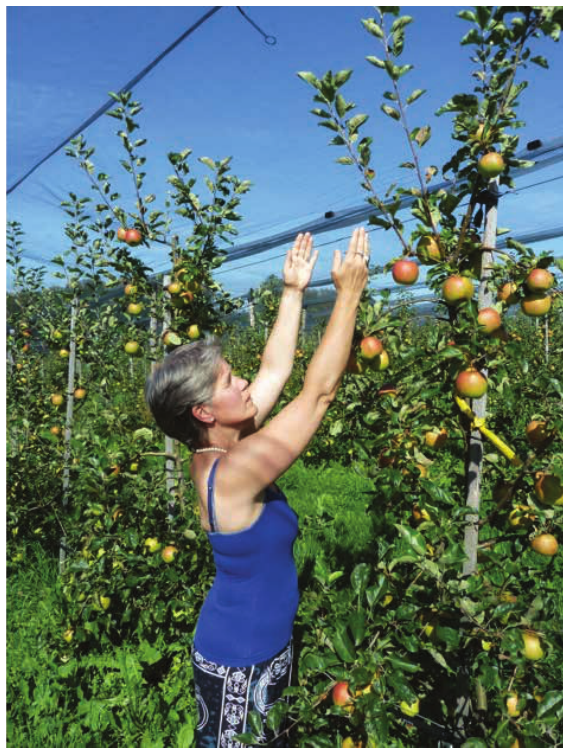
Figure 1: Tanja Baumgartner, treating an apple tree with the gesture